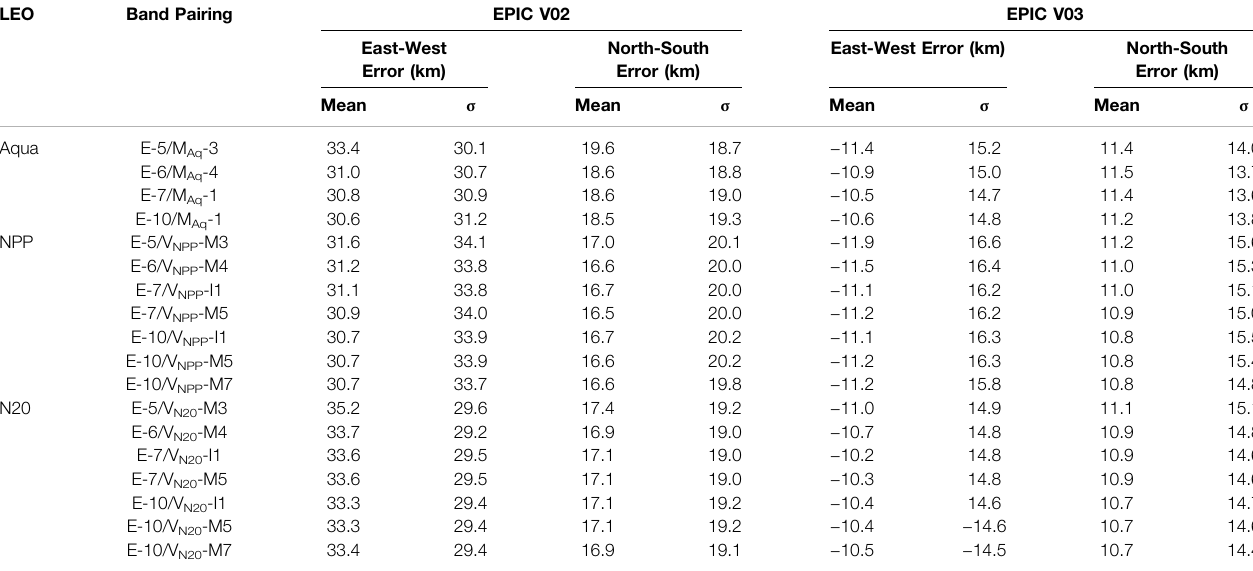
TABLE 2 | The V02 and V03 mean and standard deviation ( σ ) navigation error in the East-West and North-South direction in km with respect to Aqua-MODIS, NPP-VIIRS, and N20-VIIRS analogous band pairs with EPIC. See Table 1 for band pair nomenclature. Statistics in the table are calculated under the assumption that a 0.25 ° navigation shift translates to a distance of 25